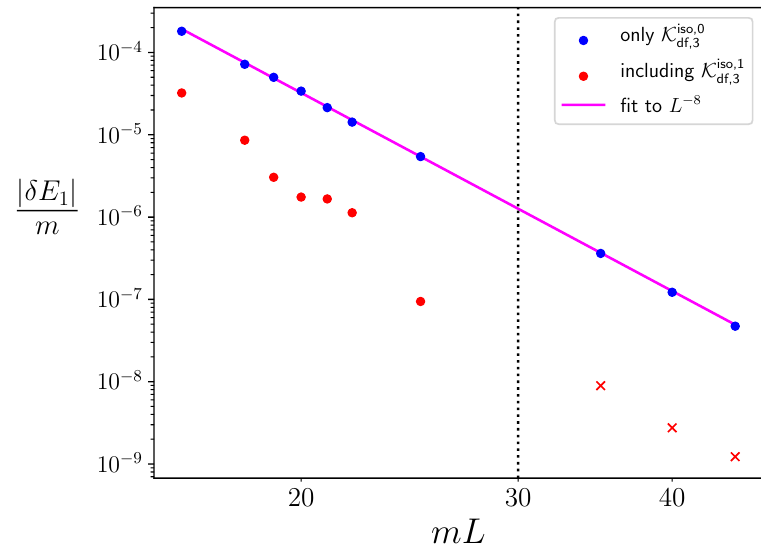
Figure 16 . j (cid:14)E 1 j as a function of mL when tuning with only a constant K iso or with the linear dependence on (cid:1) given in eq. (A.6) ((cid:12)lled red circles and crosses). The solid (magenta) line shows a (cid:12)t to the blue points assuming an L (cid:0) 8 -dependence. The vertical line indicates the value of mL at which the tuning is done. Thus the corresponding red point vanishes at this value and is not shown. (cid:14)E 1 is positive for the red circles and negative for the red crosses.